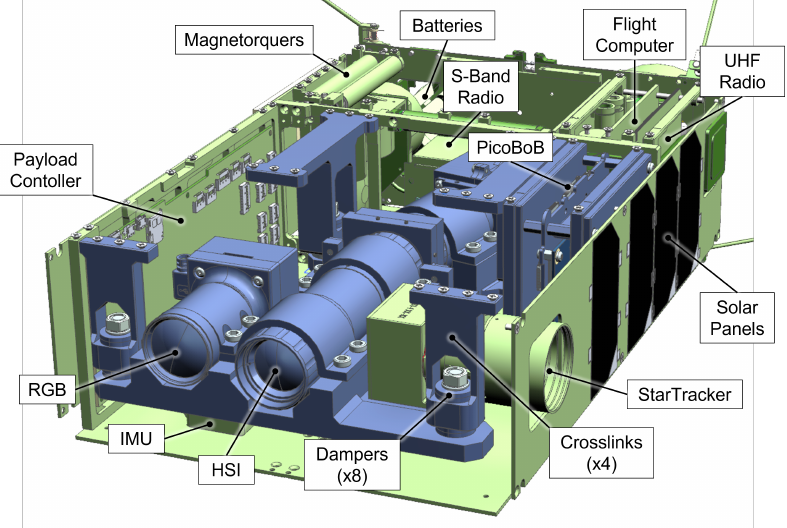
Figure 7. The satellite architecture showing NanoAvionics components (with flight heritage) in green and the NTNU payload components in blue. The 6U frame, top and front panels, and cable harness are not shown. IMU = Inertial Measurement Unit, RGB = Red-Green-Blue camera, HSI = Hyperspectral Imager, PicoBoB = picoZed + Break-Out Boards, UHF = Ultra-High Frequency. (Payload model work by E. Prentice, M. Hjertenæs, H. Galtung, T. Kaasa, and T. Tran; bus model work by NanoAvionics; COTS dampers from SMAC [41]; objectives and grating from Edmund Optics [42]; detectors from iDS [43]; slit and adapter from ThorLabs [44]—downloaded online.)